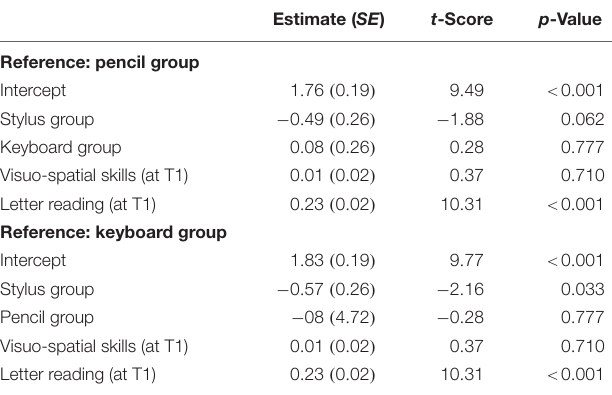
TABLE 5 | Results of estimated regression for the variable word reading to